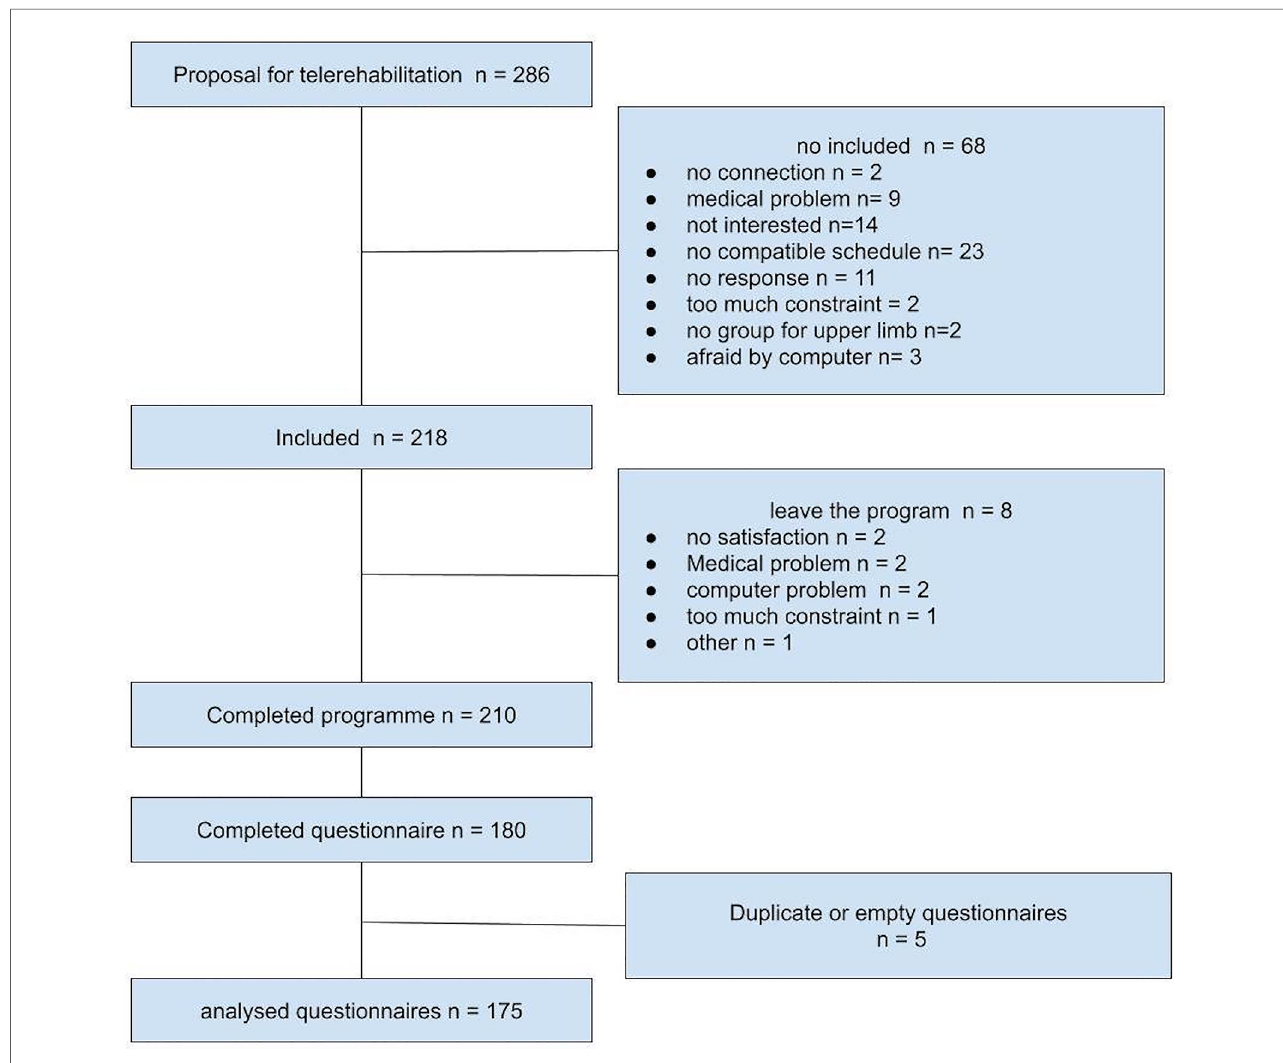
FIGURE 2 Flow chart: program integration of